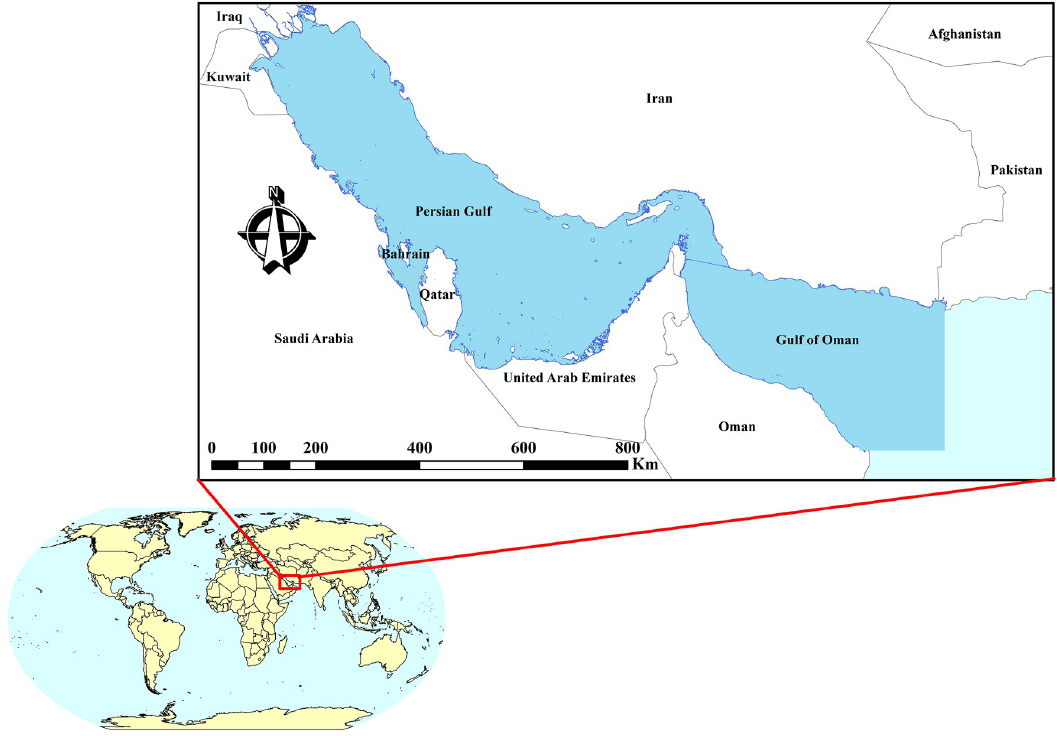
Fig 1. Map showing the study area and surrounding